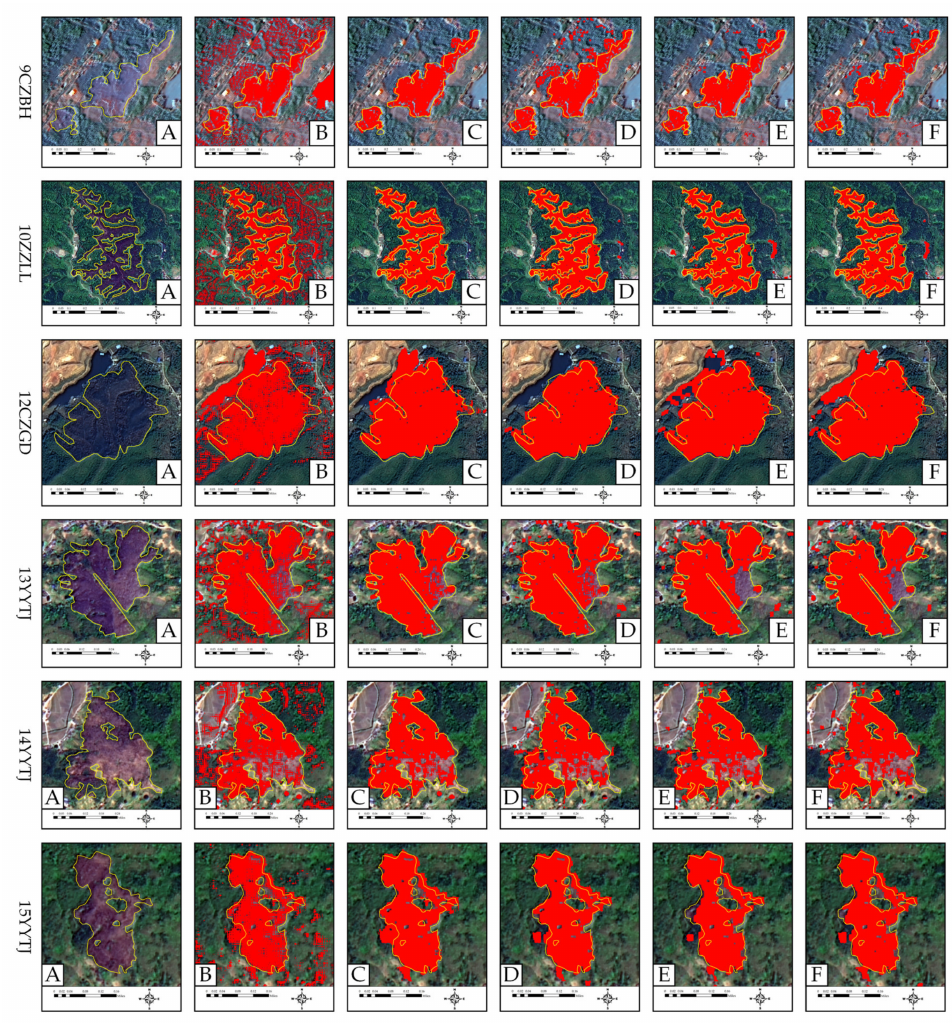
Figure 4. Comparison of BASM-notra with BASM-FERB, BASM-RF, BASM-BPNN, and BASM-SVM in minimizing misclassification and effect due to noise for Sentinel 2 image at eleven fire scar sites. The yellow line of panels ( A – F ) are fire-scar sites vector data. Panels ( B – F ) are results of burned area mapped at subpixel level, in which red represents burned area. Any red area beyond the yellow line represents misclassification and effect due to noise. Panel ( A ) is the fire-scar site based on the GF series data sets. Panel ( B ) is based on BASM-notra. Panel ( C ) is based on BASM-FERB. Panel ( D ) is based on BASM-RF. Panel ( E ) is based on BASM-BPNN. Panel ( F ) is based on